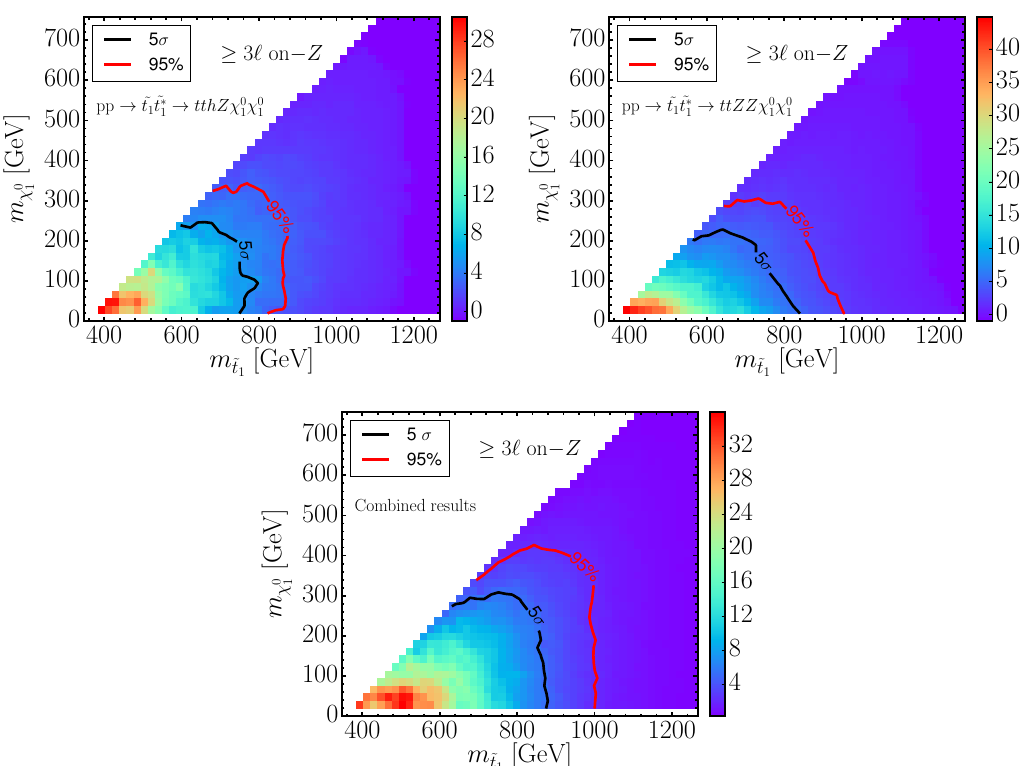
Figure 7 . The 95% CL upper limits (black curve) and 5 (cid:27) discovery reach (red curve) are shown in the plane of MSSM parameter space m ~ t (cid:22) t(cid:31) 0 =(cid:31) 0 t (cid:22) thZ E (top left) and t (cid:22) tZZ T 2 3 ! 6 3 ‘ \on- Z " signal region at the 14 TeV LHC with 300 fb (cid:0) 1 integrated luminosity. (cid:22) is (cid:12)xed to be (cid:21) M 1 + 150